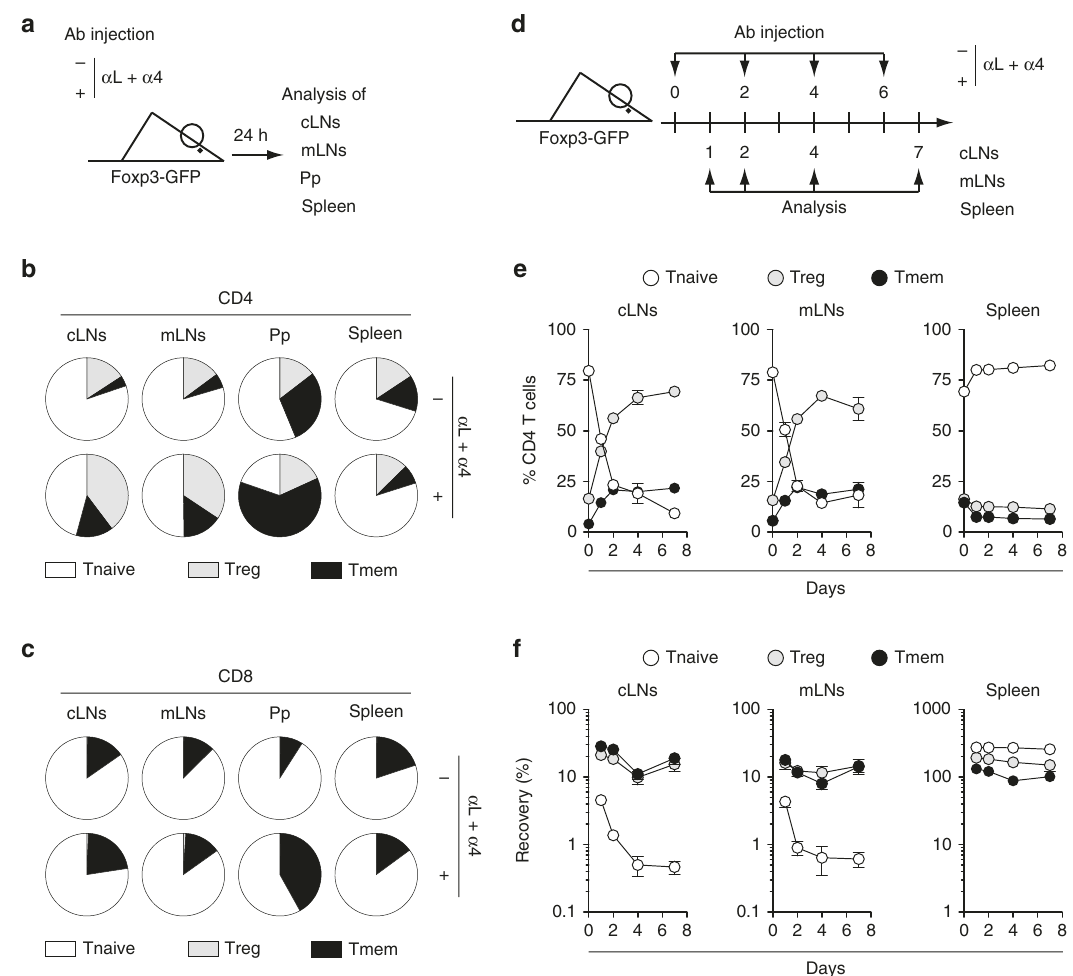
Fig. 2 Analysis of residual T cells after blocking T cell entry into LNs and Peyer ’ s Patches. a – c 6 – 12-week-old C57BL/6 Foxp3-GFP mice were injected or not i.p. with 200 μ g of anti-LFA-1 ( α L) and anti-VLA-4 ( α 4) Abs. Twenty-four hours later, cLNs, mLNs, Pp, and spleen were harvested and analyzed. a Diagram illustrating the experimental model. b Distribution of Treg, Tmem, and Tnaive cells among CD4 T cells in the indicated SLOs of treated or untreated mice. c Distribution of Treg, Tmem, and Tnaive cells among CD8 T cells in the indicated SLOs of treated or untreated mice. d , e 6 – 12-week-old C57BL/6 Foxp3- GFP mice were injected or not i.p. with 200 μ g of anti-LFA-1 ( α L) and anti-VLA-4 ( α 4) Abs every 2 days from day 0 to day 6 and SLOs were recovered for analysis at various time-points. d Experimental model. e Percentages of Treg, Tmem, and Tnaive cells among CD4 T cells are shown as means ± SEM for the indicated SLOs. f Relative absolute numbers of CD4 Treg, Tmem, and Tnaive cells in cLNs, mLNs, and spleen are shown. The percentage of recovery was calculated by dividing the absolute numbers in treated mice by the mean absolute number obtained in untreated animals. Data are means ± SEM for at least three independent experiments. Mouse clip arts were generated in ref.